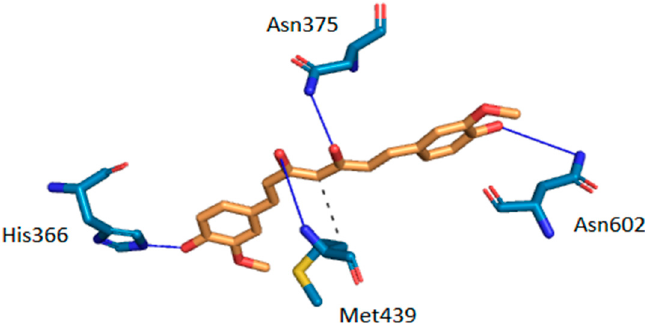
Figure 4. Intermolecular interactions between curcumin and the binding site of cAMP-specific 3 (cid:48) ,5 (cid:48) -cyclic phosphodiesterase 4D (PDE4D). Carbon atoms of curcumin are shown in orange and carbon atoms of amino-acid residues in light blue color. Oxygen atoms are red, nitrogen atoms dark blue and sulfur atoms yellow. Hydrogen bonds are depicted in dark blue and hydrophobic interactions in gray color. Hydrogen atoms are omitted for reasons of clarity.